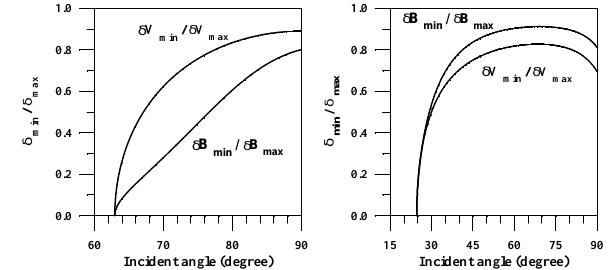
Fig. 11. Polarisation of perturbations δ V and δ V A associated with the surface magnetoacoustic wave in three mutually perpendicular planes Z = 0, Y = 0, and X = 0. Here the velocity δ V is normalised by | δ V max | , that is, the maximal distance between the centre of the ellipse and a given point of the ellipse is equal to one. Relation (16) relates the value of δ V to δ V A . The left (right) plots show the polarisation of perturbations behind the front of a fast (slow) shock wave. The symbols “ • ” indicate the initial phases of pertur- bations. The vectors of polarisation rotate counterclockwise in the wave damping off from the discontinuity.